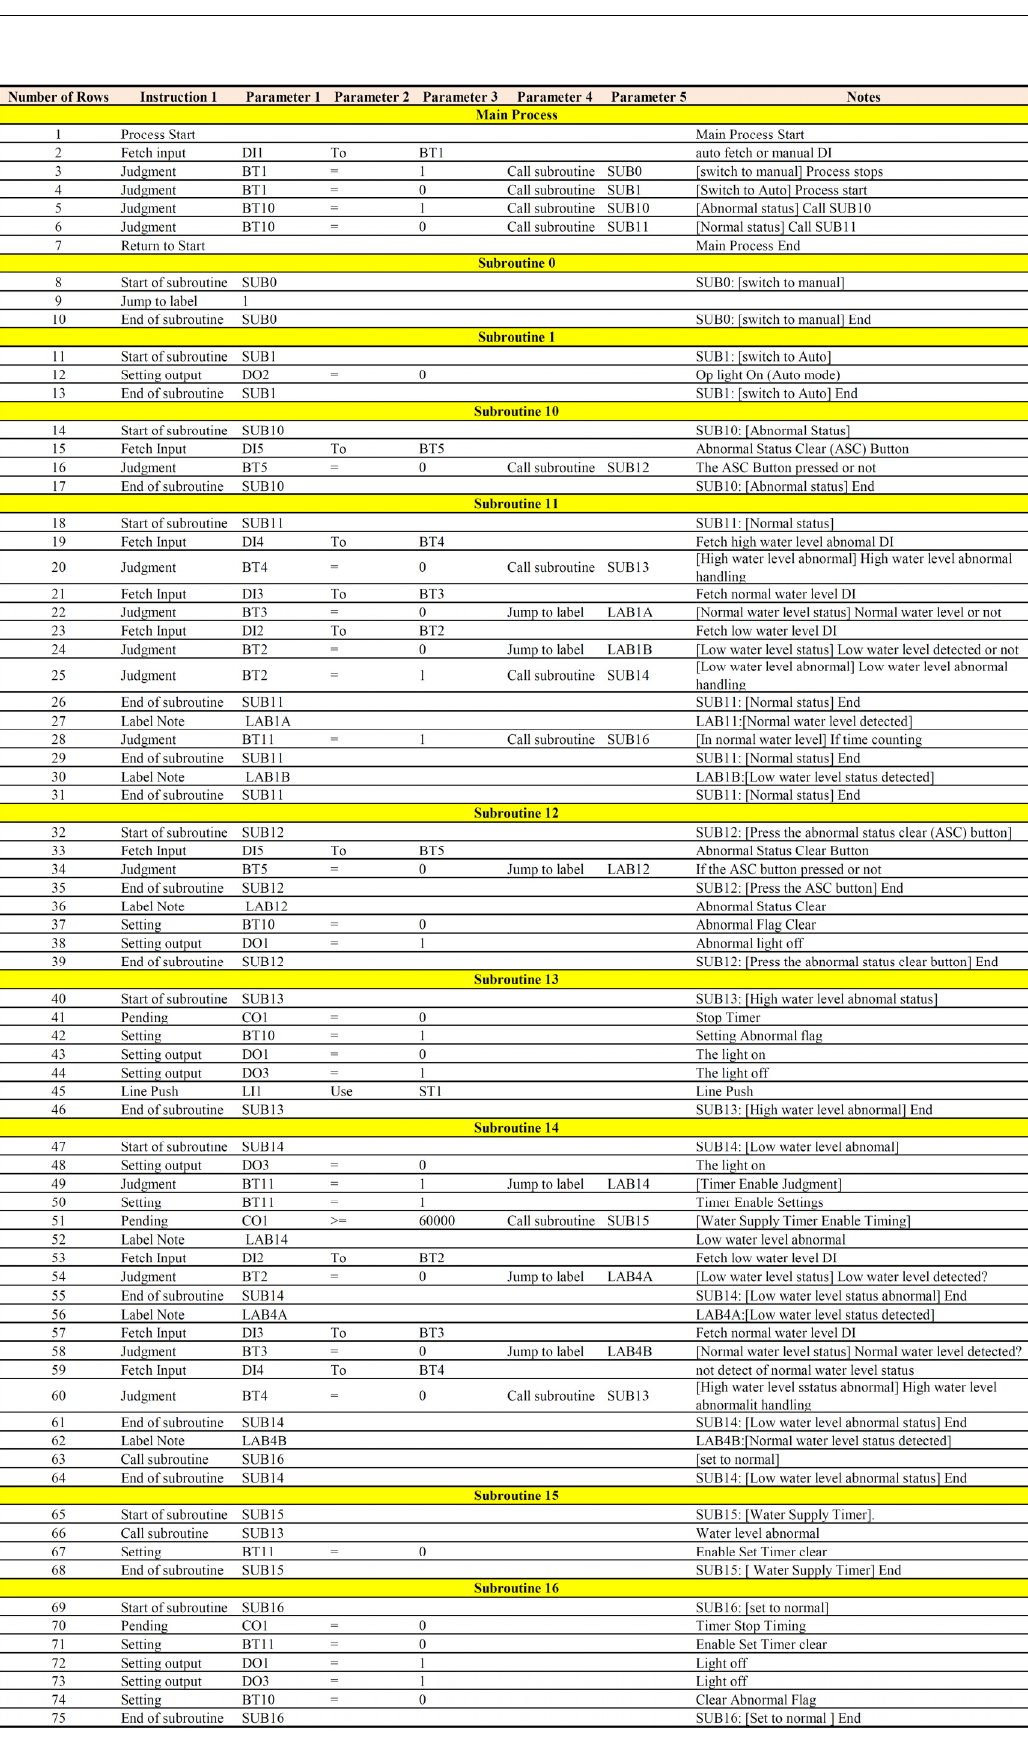
Figure 7. Process control program instructions.